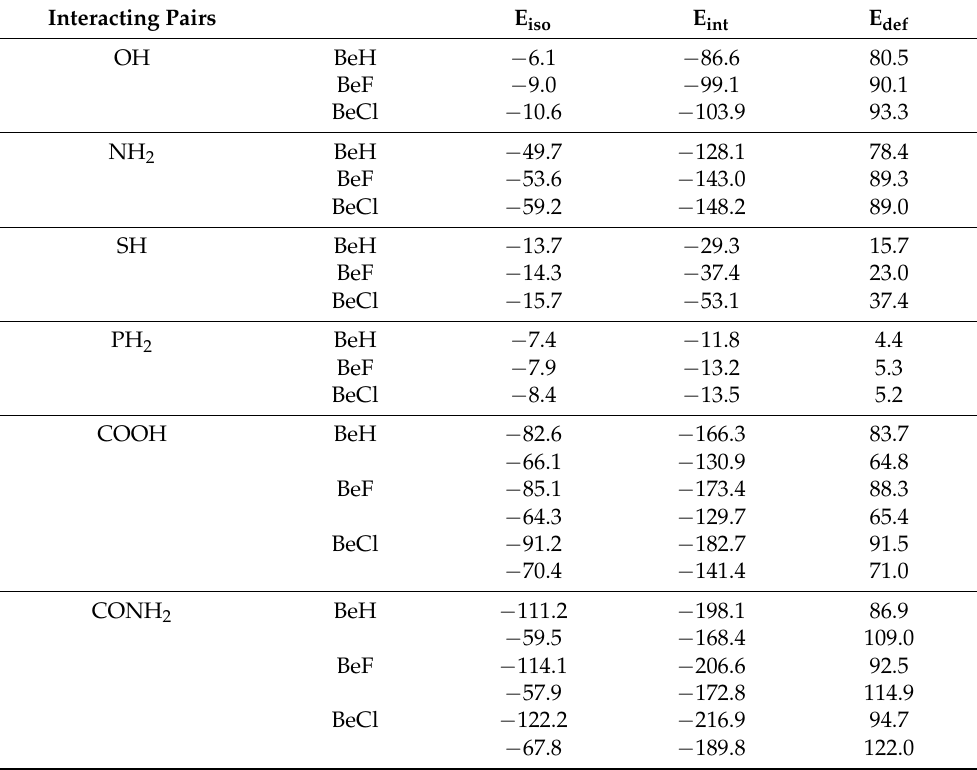
Table 3. Isodesmic energies (E iso ), interaction energies (E int ) and deformation energies (E def ) for the different compounds at the M06-2X/6-311+G(d,p) level of theory. For COOH and CONH 2 groups, the first line corresponds to O(CO) and the second line corresponds to OH/NH 2